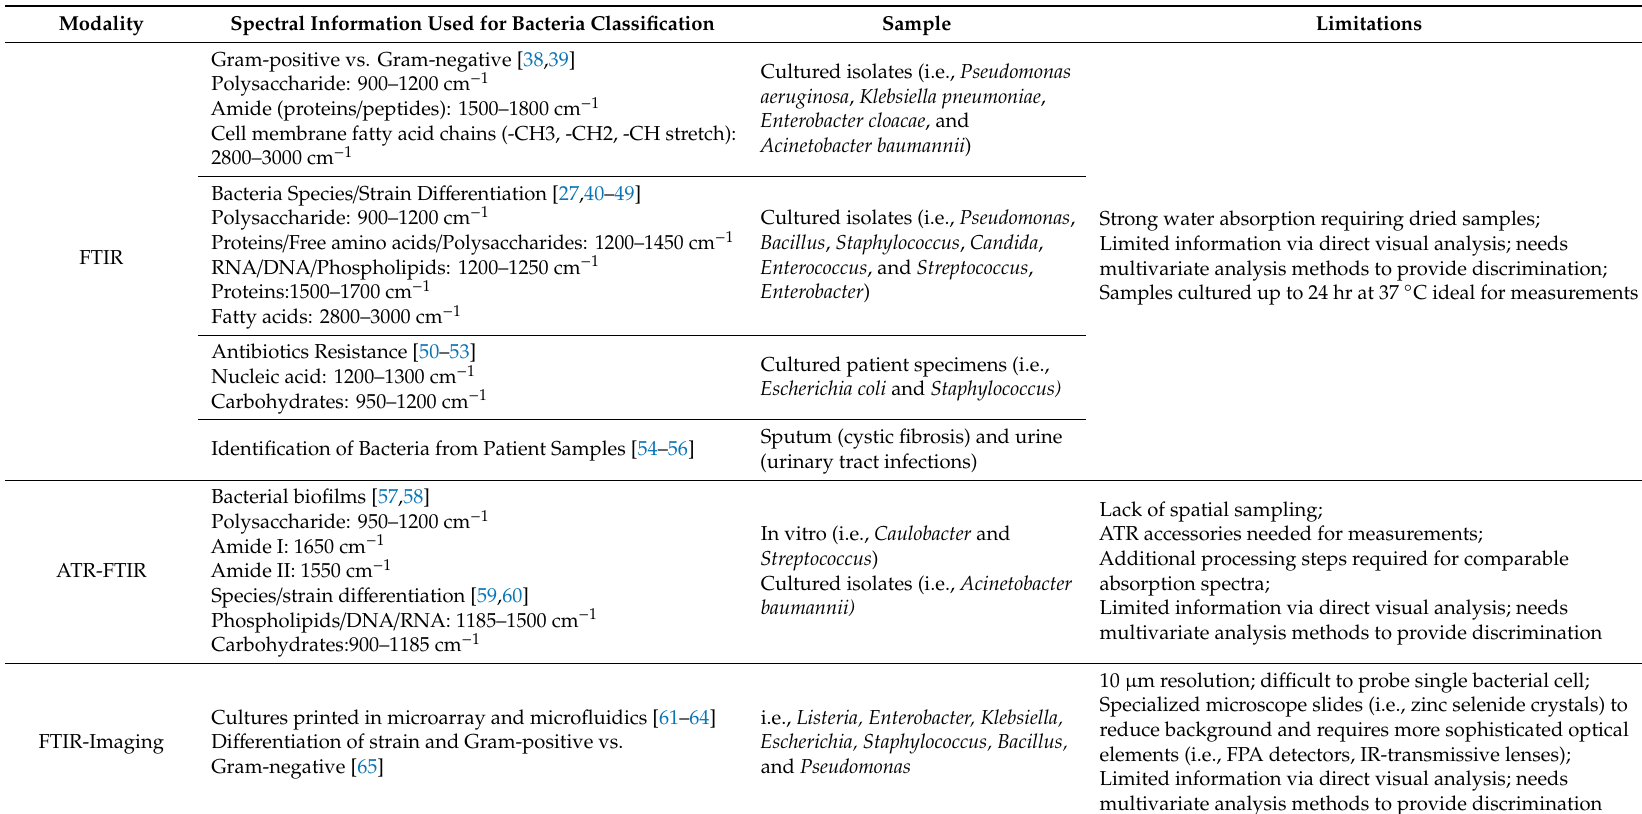
Table 1. Summary of work relating to FTIR-based systems for bacterial detection. ATR: attenuated total